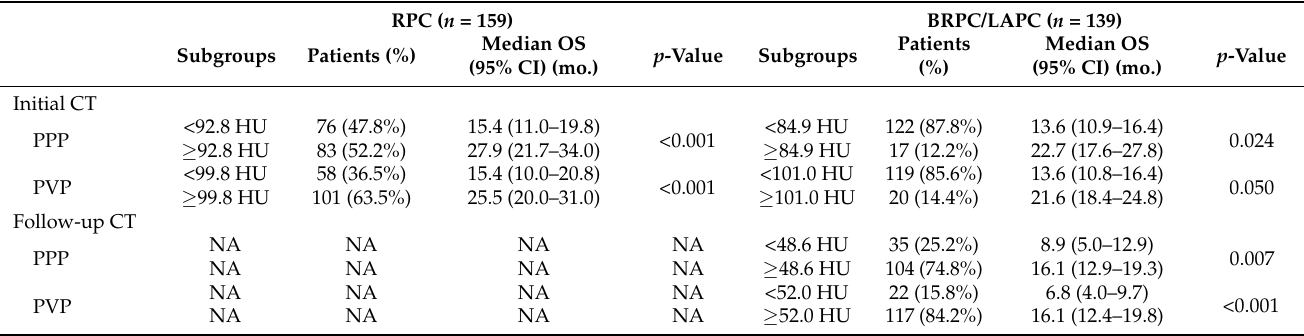
Table 2. Median overall survival according to